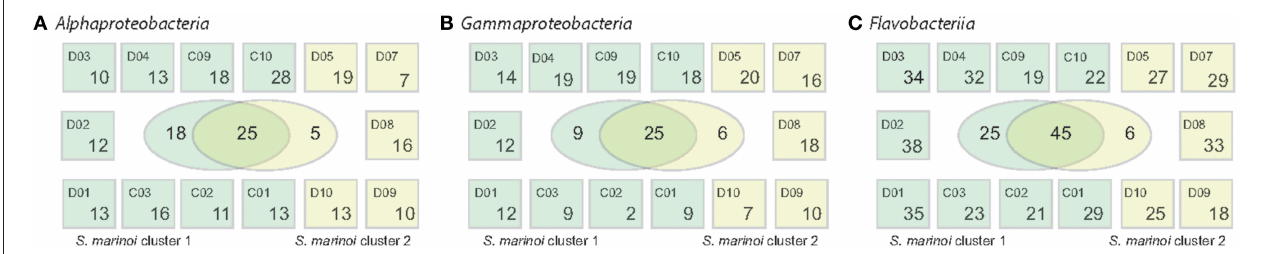
FIGURE 4 | Spatial distribution of OTUs across the Baltic Sea. (A) Alphaproteobacteria , (B) Gammaproteobacteria , and (C) Flavobacteriia . The Venn diagrams in the center of each panel depict the number of OTUs unique or shared between the stations where S. marinoi cluster 1 (dark green) or S. marinoi cluster 2 (light green) dominated. Small boxes depict how many OTUs of each major taxon that were detected at each station (numbers include OTUs that occur at single or multiple stations). Only OTUs with relative abundances > 0.1% are